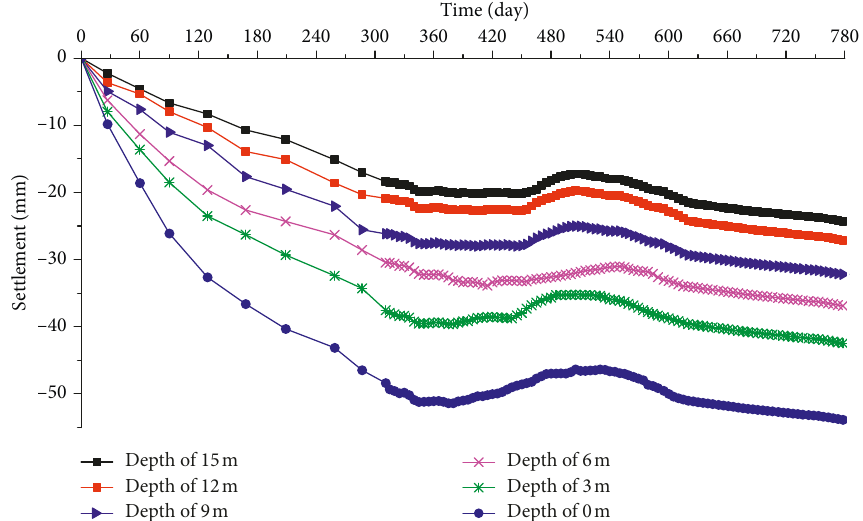
Figure 5: Variation of the settlement with time for different depths of the road